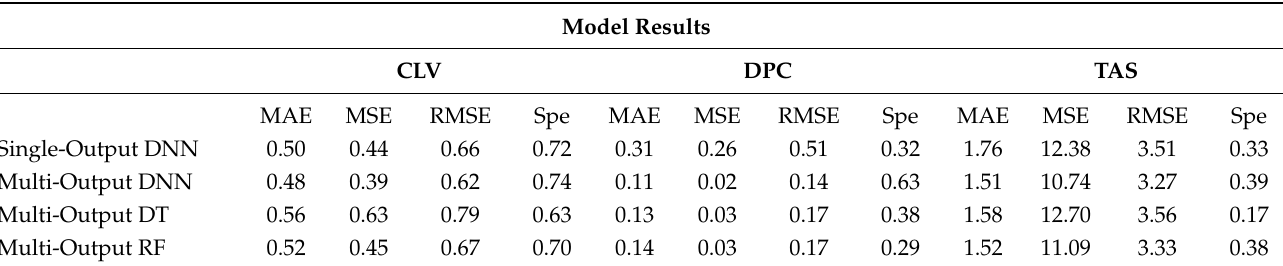
Table 4. Model results based on MAE, MSE, RMSE, and Spearman (Spe). Model Results